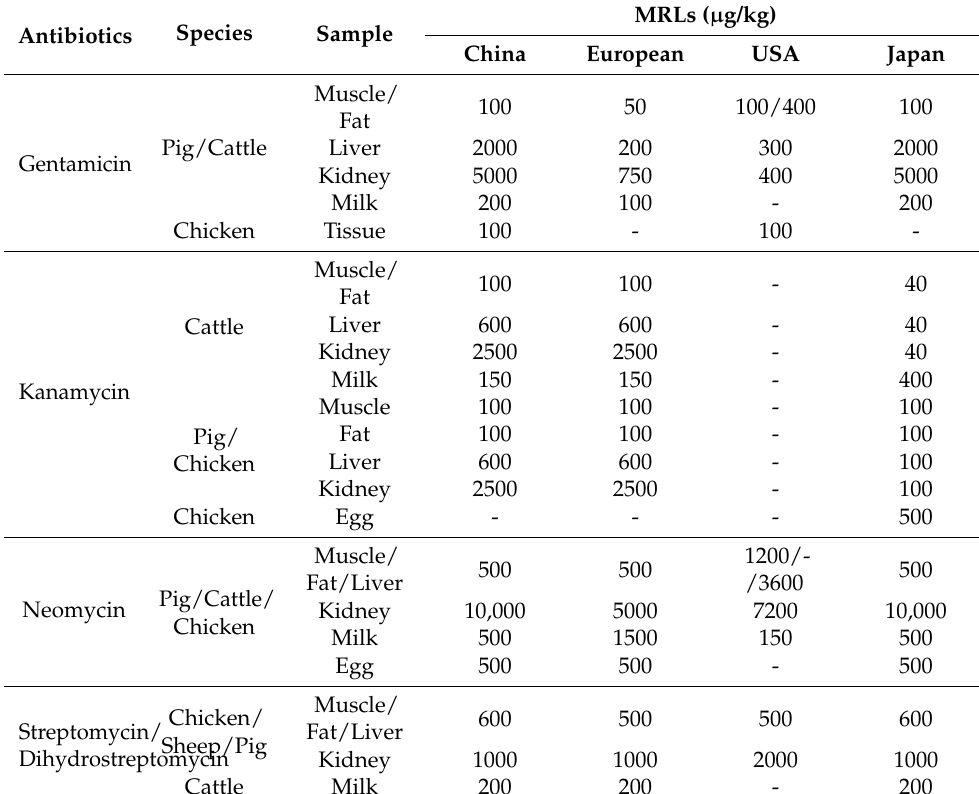
Table 1. Maximum residue limits (MRLs) of some aminoglycosides in various countries.